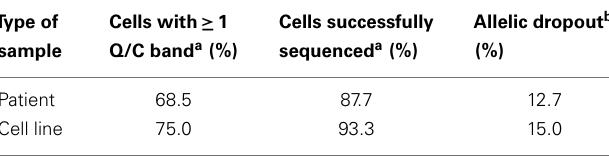
Table 3 |WGA and sequencing of fixed single cells